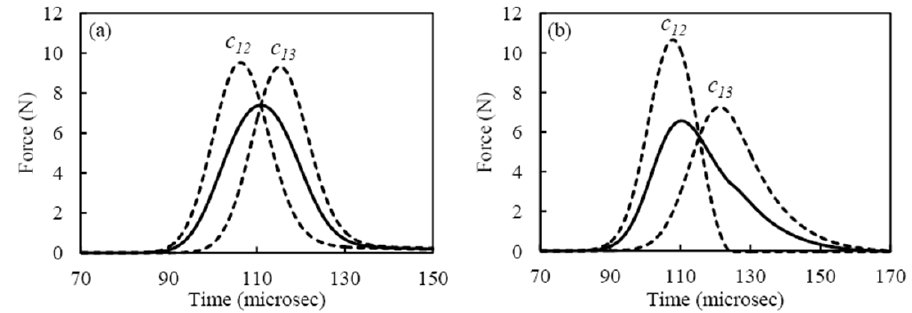
Figure 5. Discrete particle model results showing the temporal force profile at some contact points (dashed lines) and as measured by three sensors (solid lines): ( a ) bead sensor, ( b ) piezo rod, ( c ) magnetostrictive